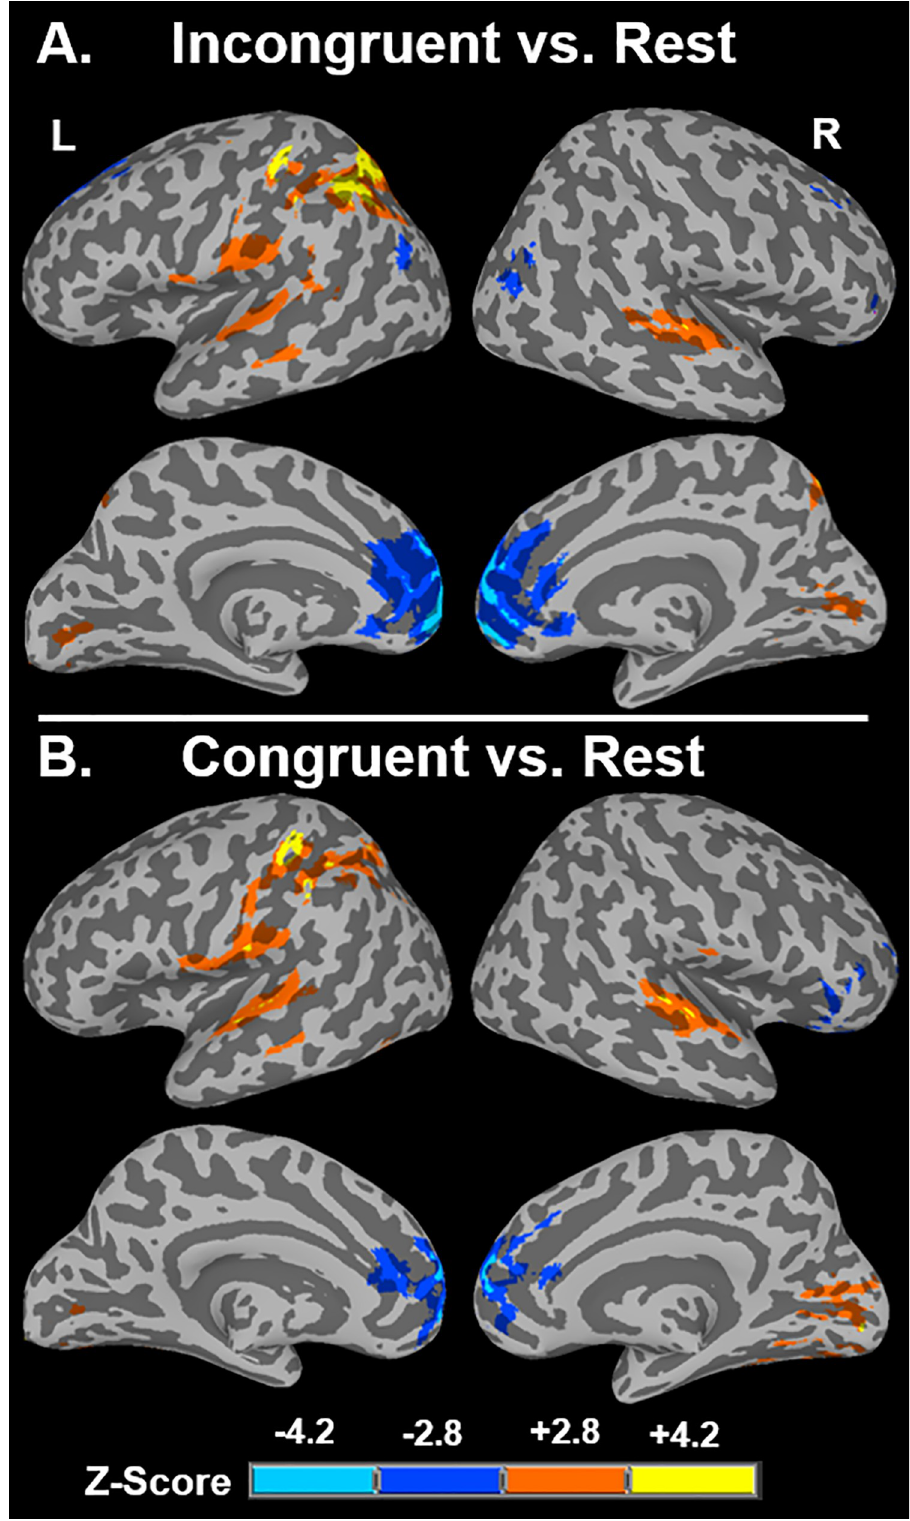
Fig 3. Activation for incongruent and congruent trials compared to rest. (A) Voxels whose activation is greater for AV incongruent trials than rest trials (orange and yellow) or greater for rest than incongruent trials (blue). (B)